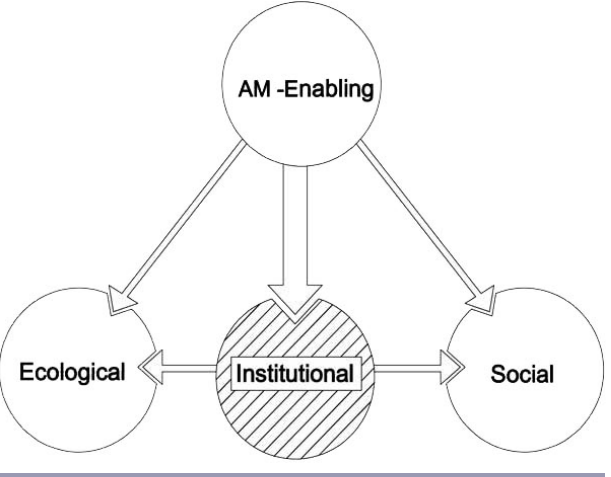
Fig. 1 . Schematic representation of our "hinge"